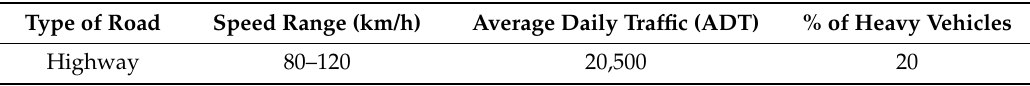
Table 1. Examined road traffic features.